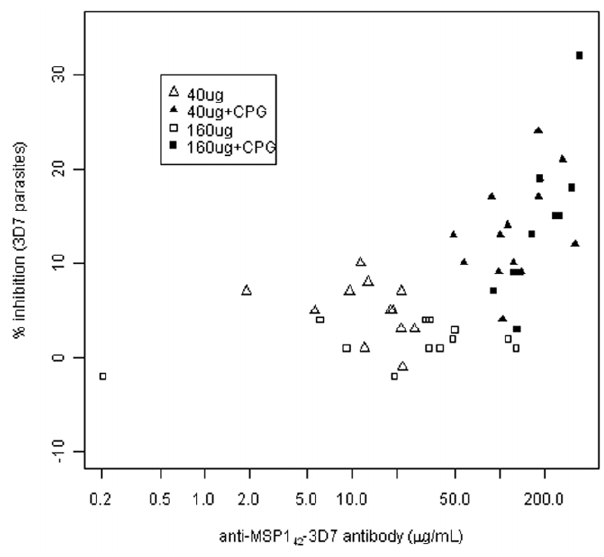
Figure 4. In vitro growth inhibition levels plotted against anti- MSP1 42 -3D7 antibody for 3D7 homologous parasites.